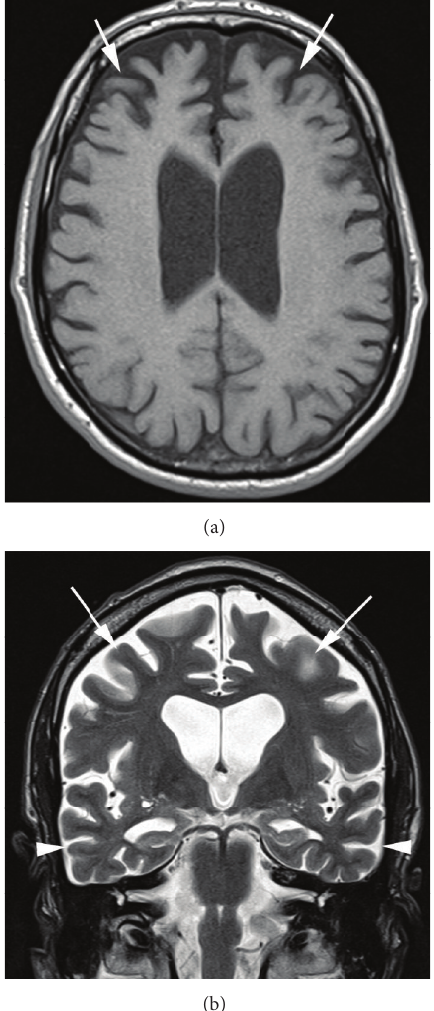
Figure 1: (a) An axial T1-weighted MR image of the brain demon- strating severe bilateral frontal lobe atrophy (arrows) compared to theparietallobes.(b)AcoronalT2-weightedMRimagedemonstrat- ing severe bilateral frontal lobe atrophy (arrows) as well as bilateral temporal lobe atrophy